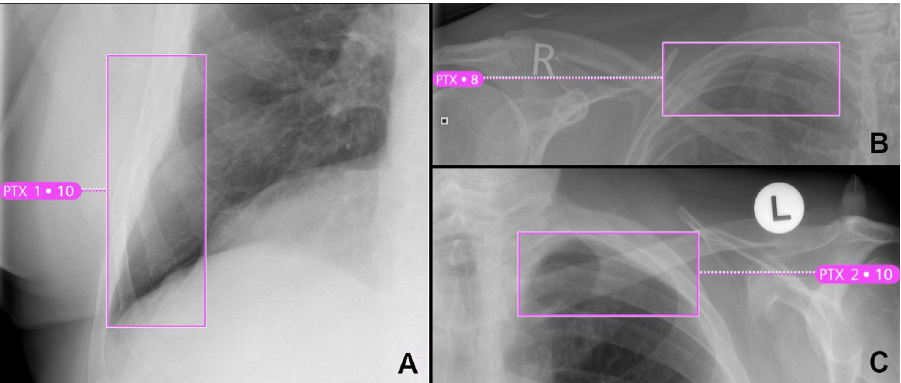
Figure 7. Three examples of false positively indicated pneumothoraces (A-C) by the AI Rad Companion Chest